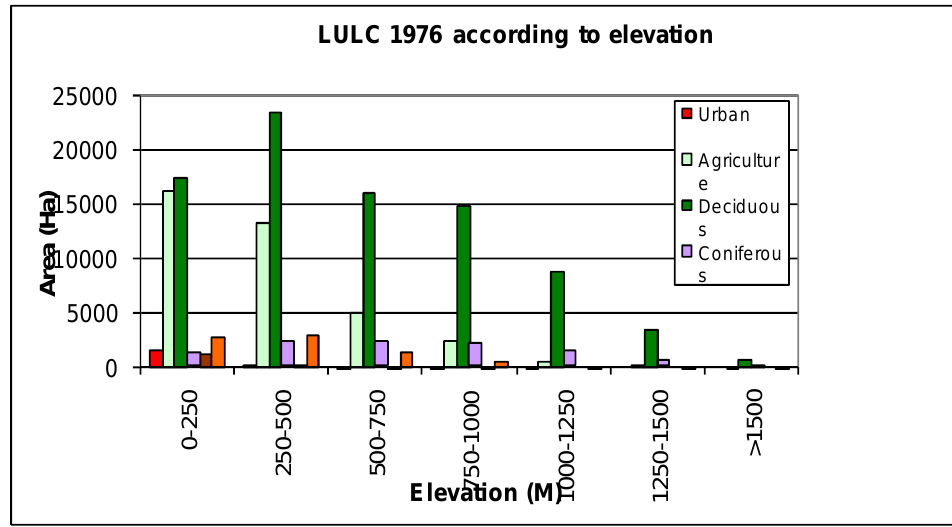
Figure 5. Land use\land cover values that belong to 1976 according to altitude.